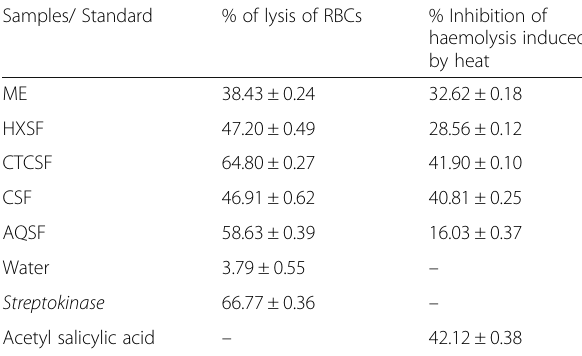
Table 2 Thrombolytic and membrane stabilizing activities of L. speciosa flower extract and soluble fractions Samples/ Standard